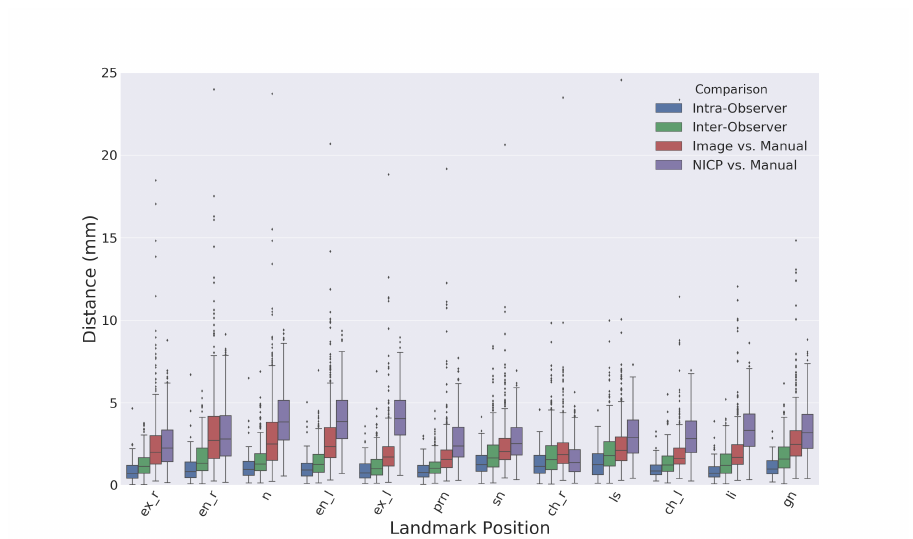
algorithm. Table 1 records the means and standard deviations of the distributions visualized in Figure 6.